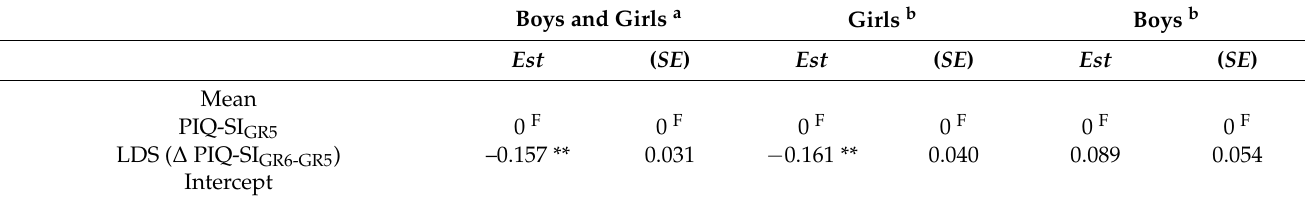
Table 4. Unconditional latent difference score (LDS) models of the